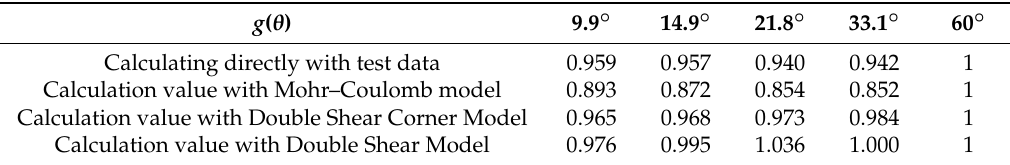
Table 7. The g ( θ ) on π plane whose hydrostatic stress is 30.9 MPa for 3.5% cement content cement-stabilized macadam.